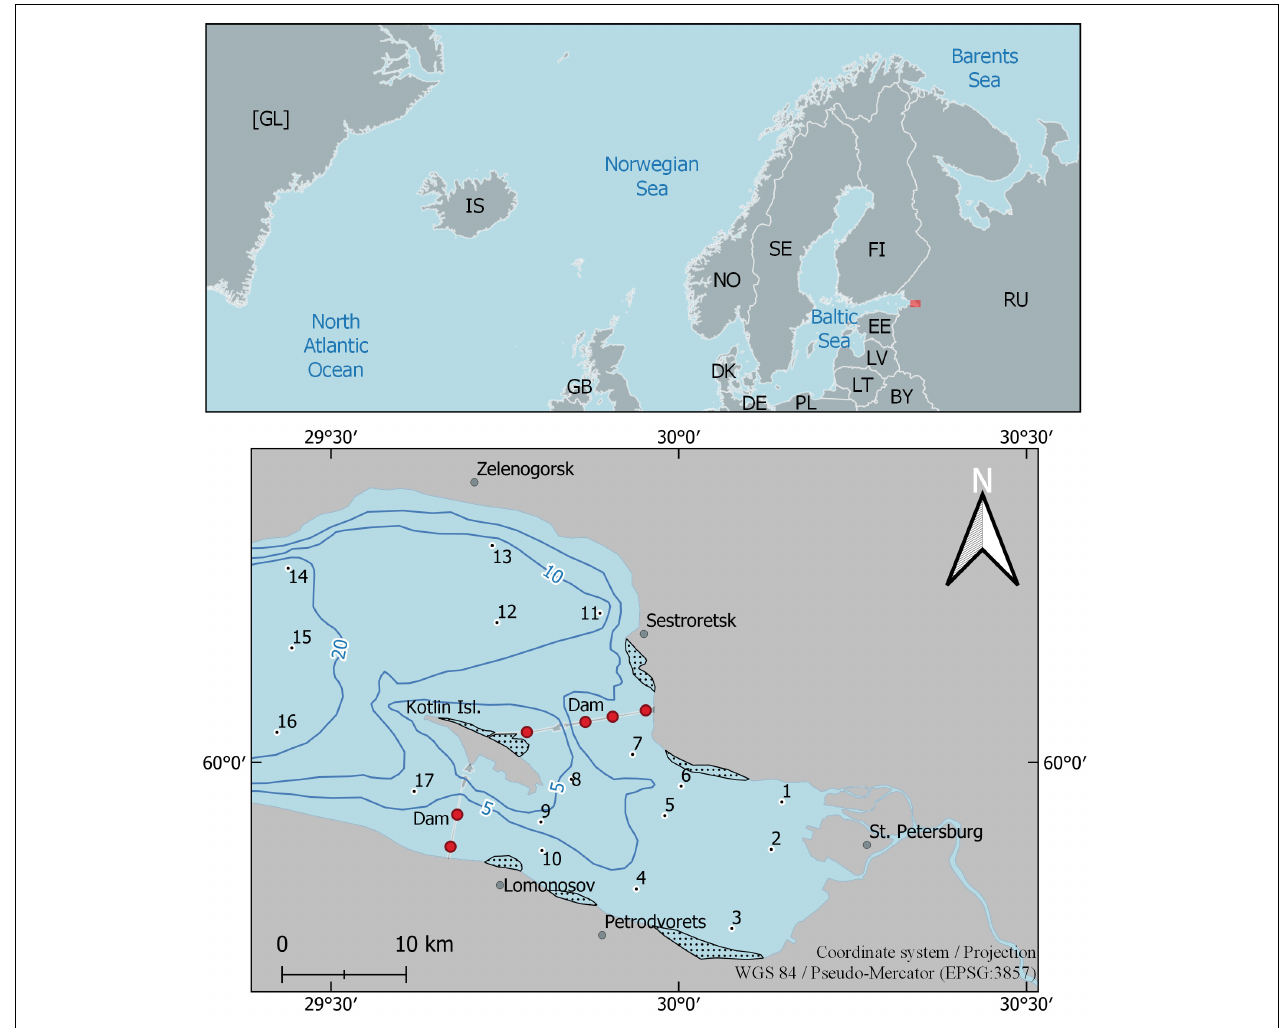
FIGURE 1 | The upper and middle parts of the Neva Estuary with indication of sampling stations (1–17). Black lines: isobaths of 5, 10, and 20 m. Areas with dots indicate dense reeds. C1, C2—gates for vessels; D1–D6—waters gates in the St. Petersburg Flood Protection Facility. Red rectangles—the location of the Neva Estuary. Two-letter country codes are given according to ISO 3166-1 alpha-2 (International Organization for Standardization, 2020). TABLE 1 | Averaged e nvironmental variables for the upper and middle parts of the Neva Estuary during the study period. Parameter Minimum Maximum